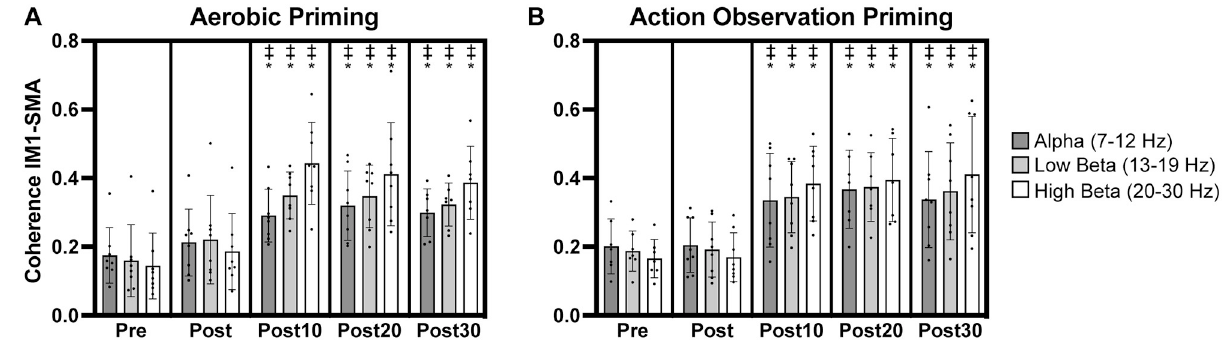
Fig 3. Coherence in leads overlying left primary motor (lM1) cortex and supplementary motor area (SMA). Significant increases in alpha, low beta, and high beta lM1-SMA coherence occurred after aerobic (A) and action observation (B) priming. Individual participant data points illustrated along with group averages and standard deviations. ‡ indicates significant increase from pre timepoint. * indicates significant increase from post timepoint.